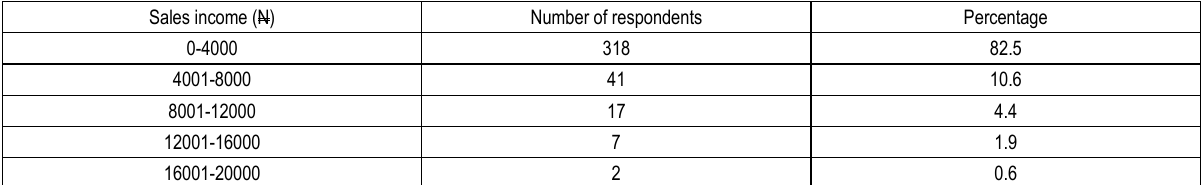
Table 4. Distribution of daily sales (₦) among respondents